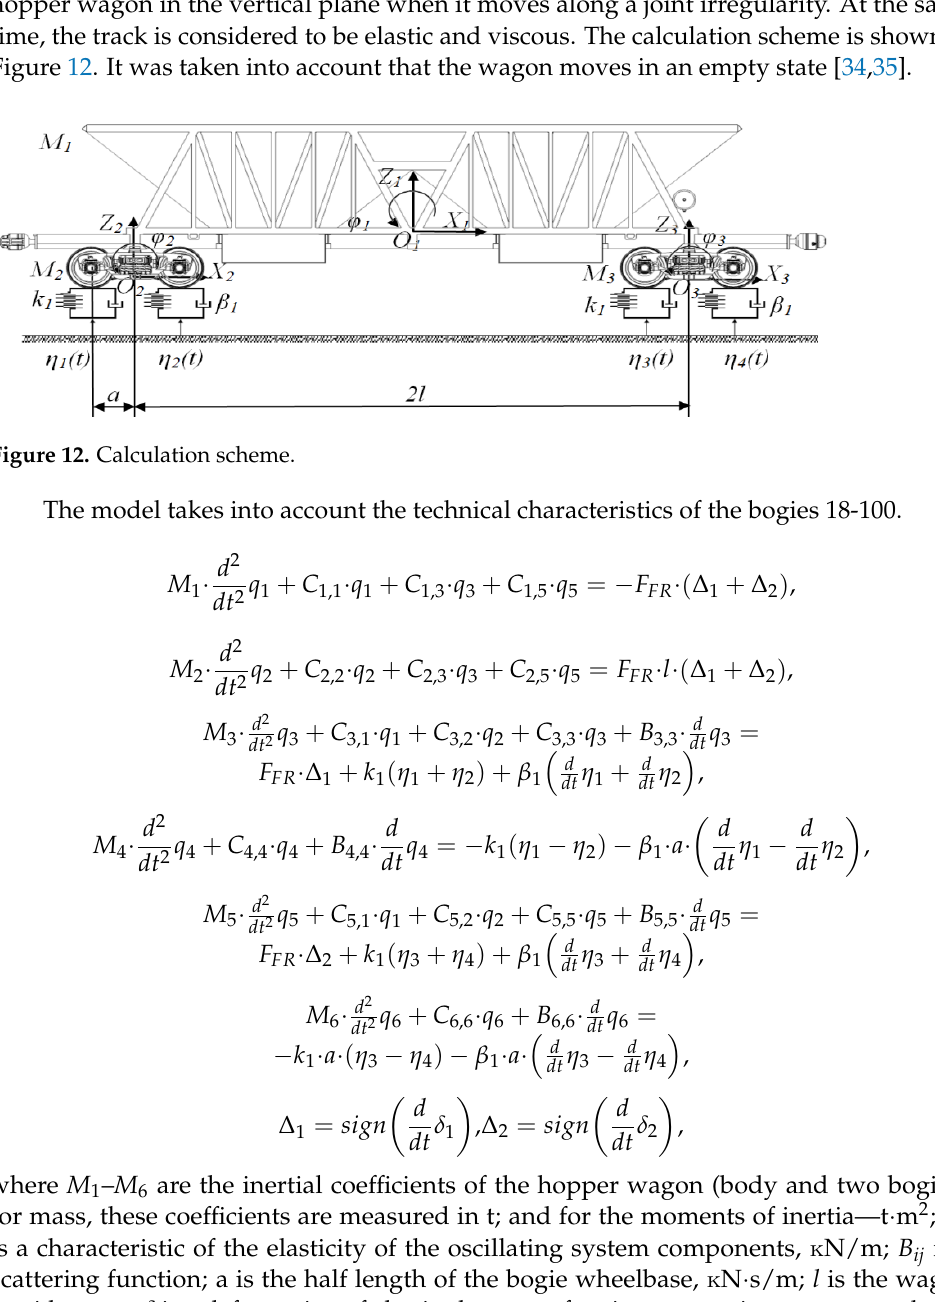
Figure 11. Displacements in the nodes of the hopper wagon.